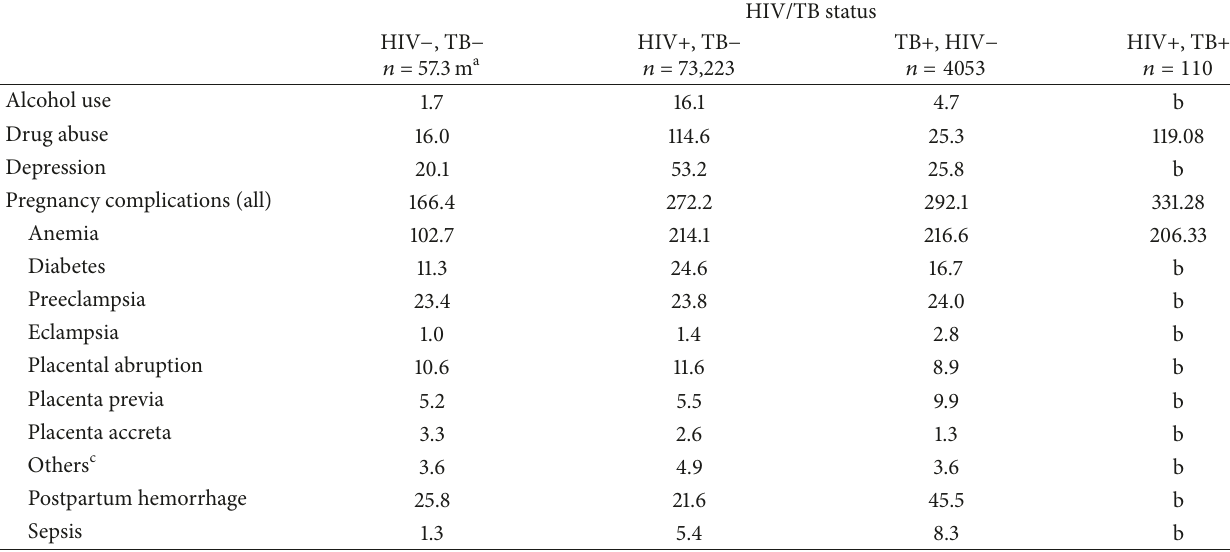
Table 2: Rates (per 1,000 hospitalizations) of alcohol use, drug abuse, depression, and complications of pregnancy among pregnancy-related admissions, by HIV/TB status, United States, 2002–2014.